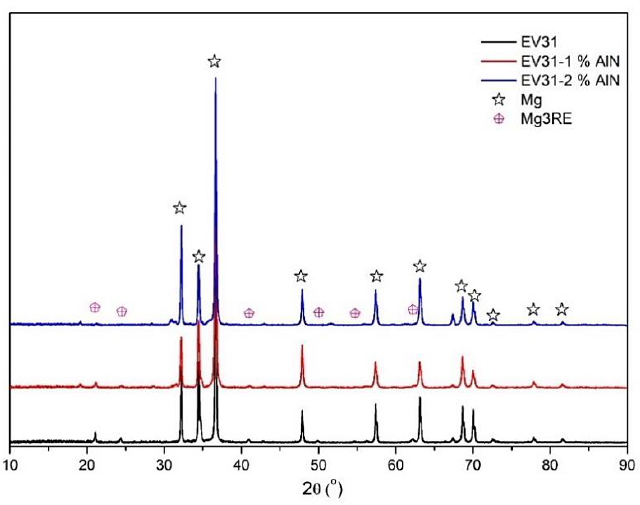
Figure 4. XRD patterns of as-cast modified EV31, modified EV31-1%AlN and modified EV31- 2%AlN.